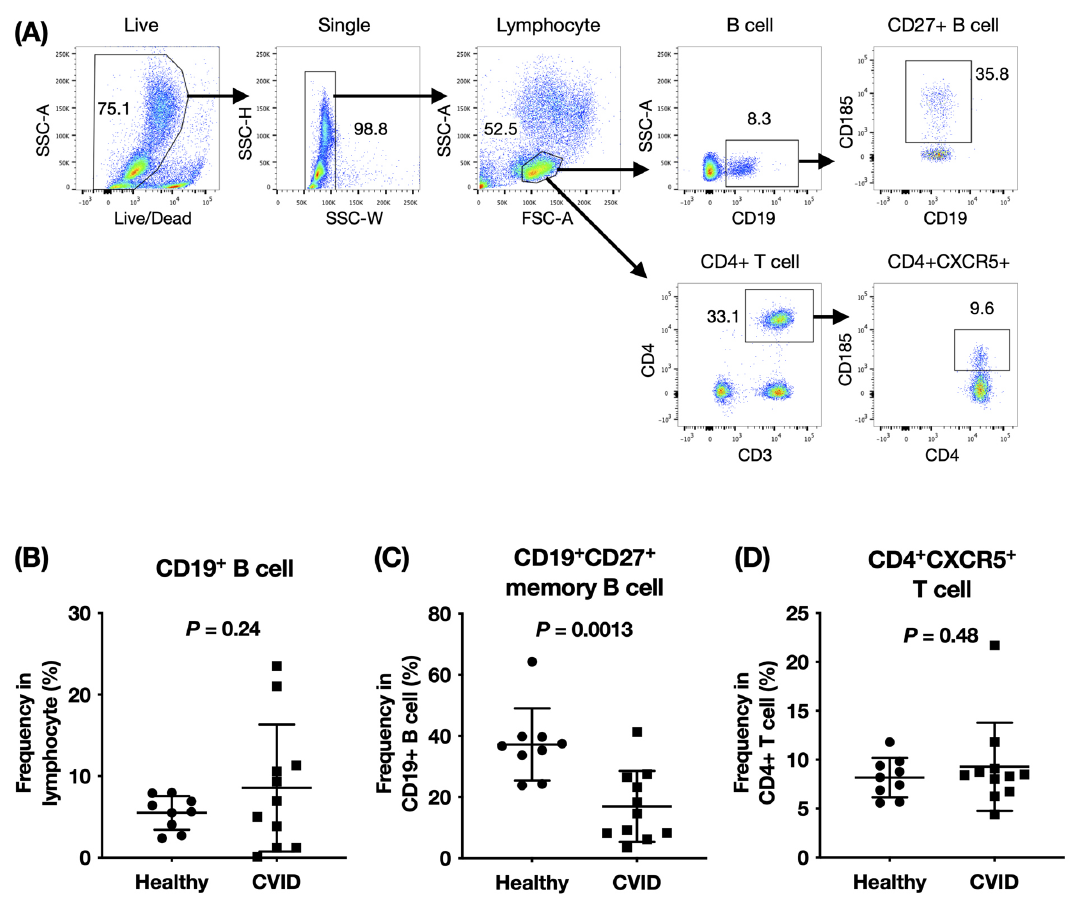
Figure 1. Peripheral blood lymphocyte composition in patients with CVID and healthy controls. PBMCs were stained ex vivo for surface expression of CD3, CD4, CD19, CD27, and CXCR5. (A) Representative step-wise gating strategy of lymphocytes, B cells, CD27 + memory B cells, CD4 + T cells, and CD4 + CXCR5 + T cells. Data shown is from 1 representative healthy subject. In 9 healthy controls and 11 patients with CVID, the frequencies of (B) B cells, (C) CD27 + memory B cells, and (D) CD4 + CXCR5 + T cells were compared using the unpaired t test with Welch’s